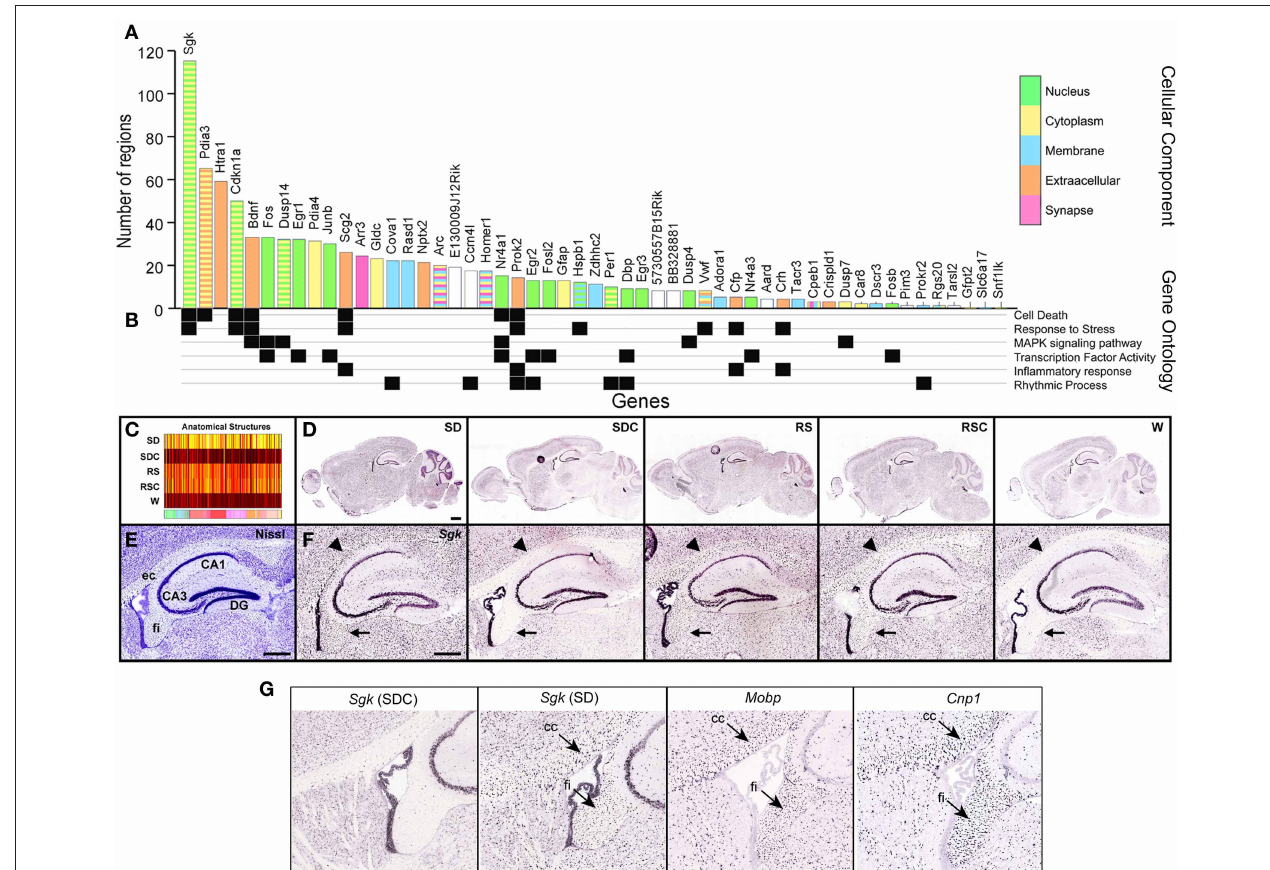
widespread upregulation by both SD and by time-of-day (RS, RSC). (D,F) ISH data for Sgk1 across five behavioral conditions on a whole sagittal brain section (D) and in the hippocampus at high magnification (F) . Sgk1 is upregulated selectively in oligodendrocyte–rich white matter tracts including the external capsule (ec, arrowhead) and fimbria (fi, arrow), delineated in a plane-matched Nissl-stained section (e) . (g) Sgk expression in SDC strongly resembles the expression patterns of two well-known oligodendrocyte markers, Mobp and Cnp1 . DG, dentate gyrus; CA1, CA3, hippocampal subfields. Scale bars: (D) : 1 mm; (e,F) : 500